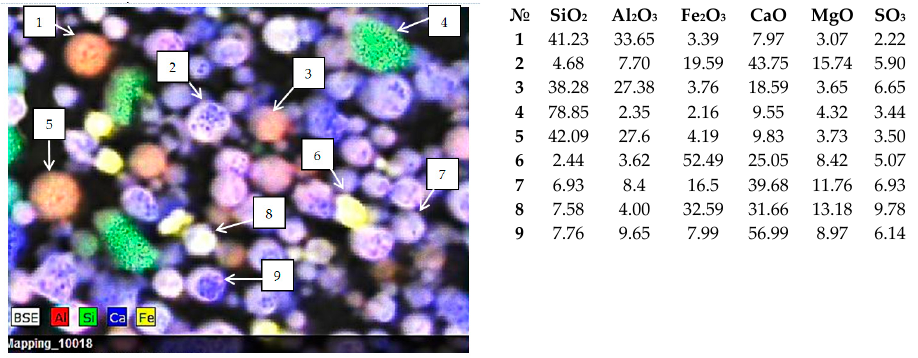
Figure 1. SEM image of the fine narrow fraction, indicating the areas of analysis and the individual globules analyzed in these areas.